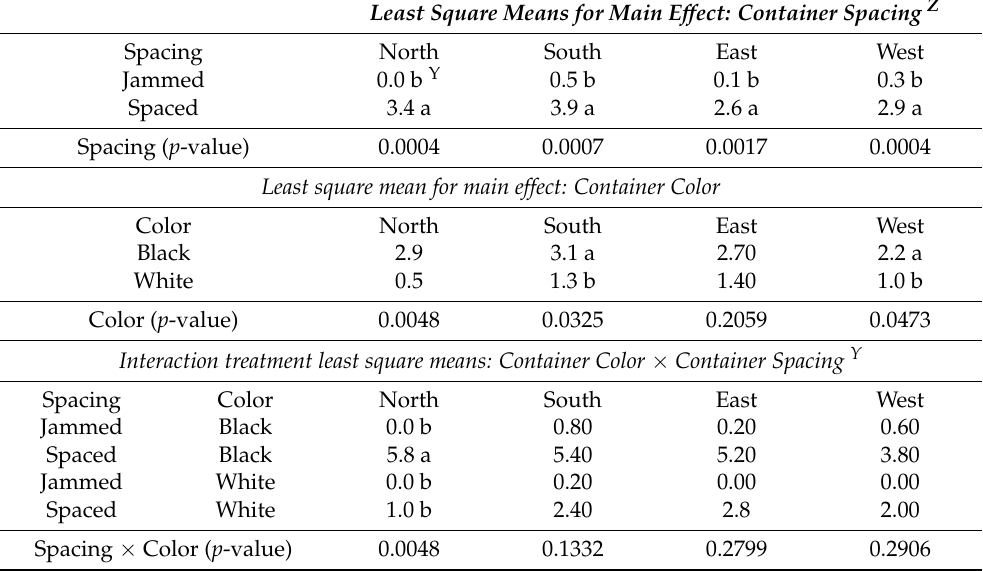
Table 4. Comparisons of time units (30 min) over 38 ◦ C associated with container color and spacing by directional root ball quadrants ( n = 5